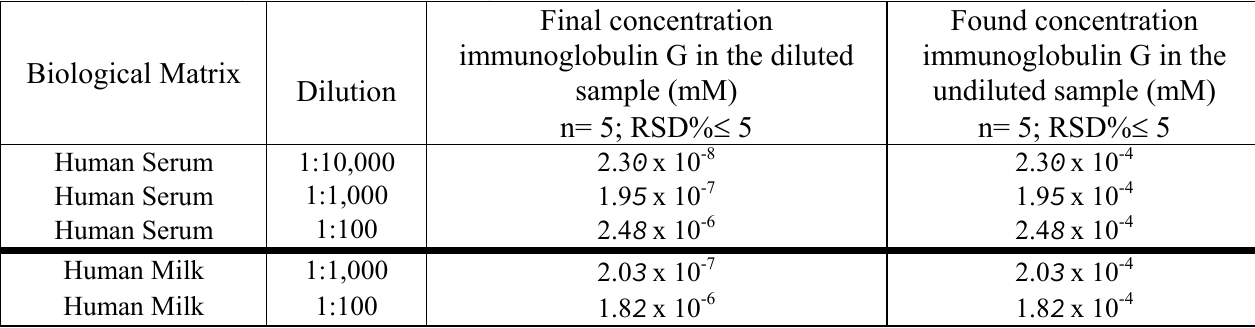
Table 6. Determination by new immunosensor of immunoglobulin G in human serum and human milk (at different dilutions).